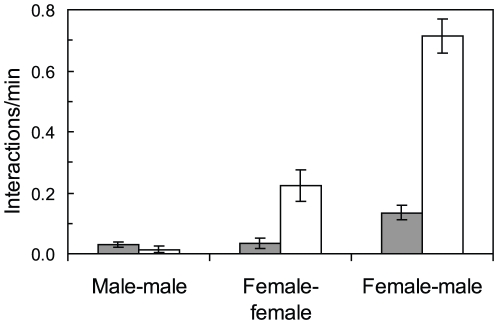
Comparison of males and female encounter rates between locations.Frequency of encounters per minute (± SE) for Halichoeres miniatus at Orpheus Island (grey) and Lizard Island (white) sampling locations. Based on the 15 min observations of 7 males and 7 females at each location.